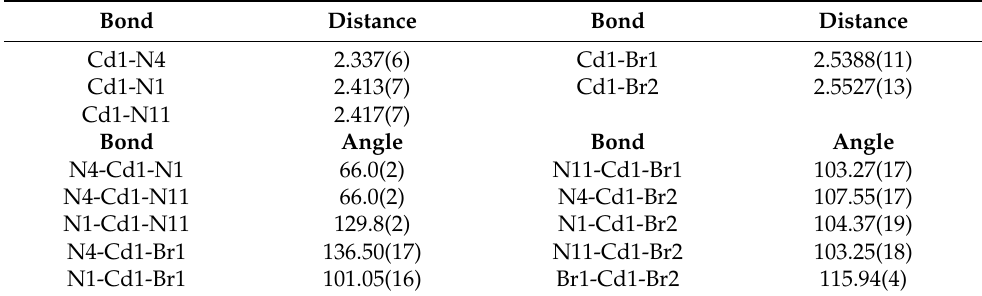
Table 2. Selected bond distances (Å) and angles ( ◦ ) for the [Cd(BPMT)Br 2 ]